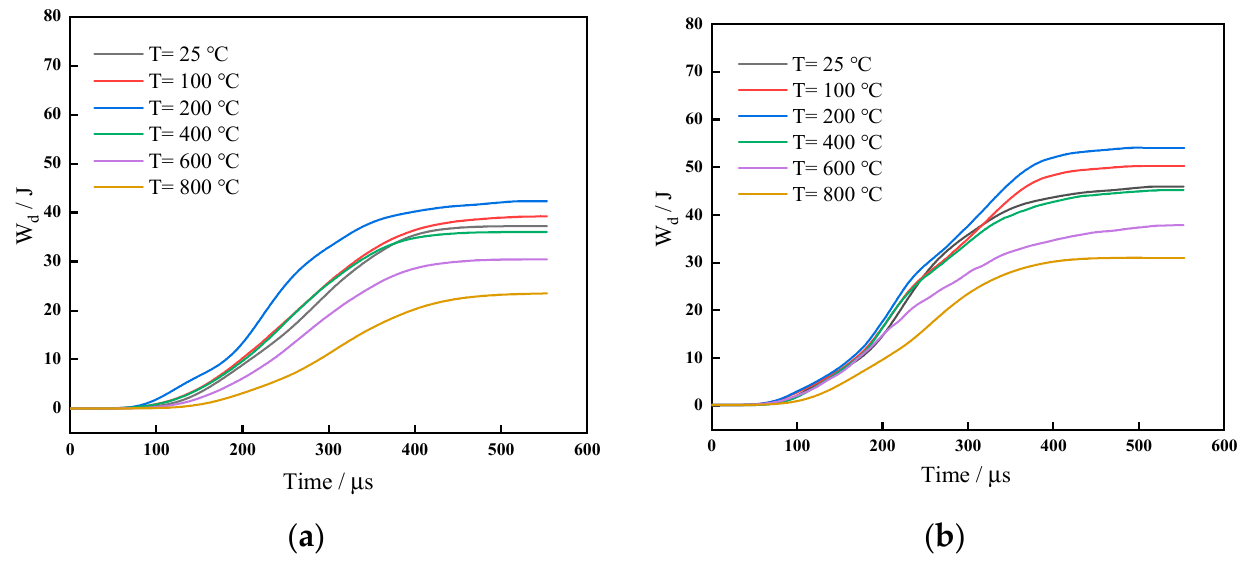
Figure 9. Time history curve of dynamic splitting dissipation energy of concrete under different temperature groups:( a ) PC; ( b ) S1PP0.2.